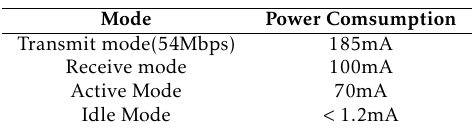
Fig. 11. The comparison of transmission delay before and after use of optimization mechanism Figure 12. The comparison of transmission delay before and after use of optimization mechanism In addition, the delayed transmission e ff ect on latencies for packets was tested. The experiment was carried out by running App under di ff erent network environments. As shown in Fig. 12, the proposed mechanism consumed 4.64% of total time more than original mechanism for Youku. Specifically, it took 1.392 seconds more time compared with the original mechanism when playing the Angry Bird. More accurately, the proposed mechanism imposed greater influence on background packets (Chrome/ Wechat, etc.) than foreground packets (Skype/ Youku,